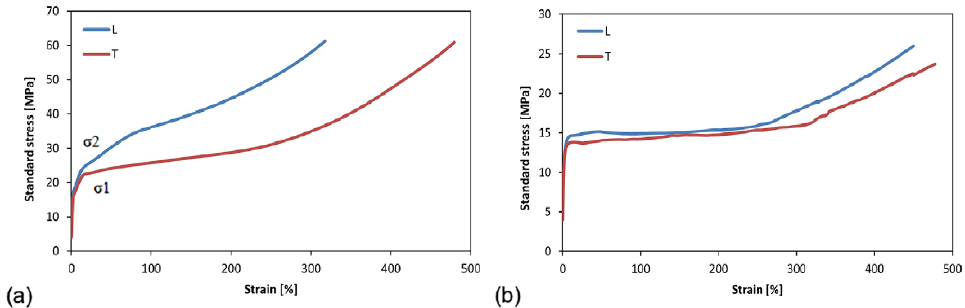
Figure 1. Typical stress-strain curves for the ETFE ( a ) and PFA ( b ) non-aged film. L = longitudinal specimen, T = transverse specimen.